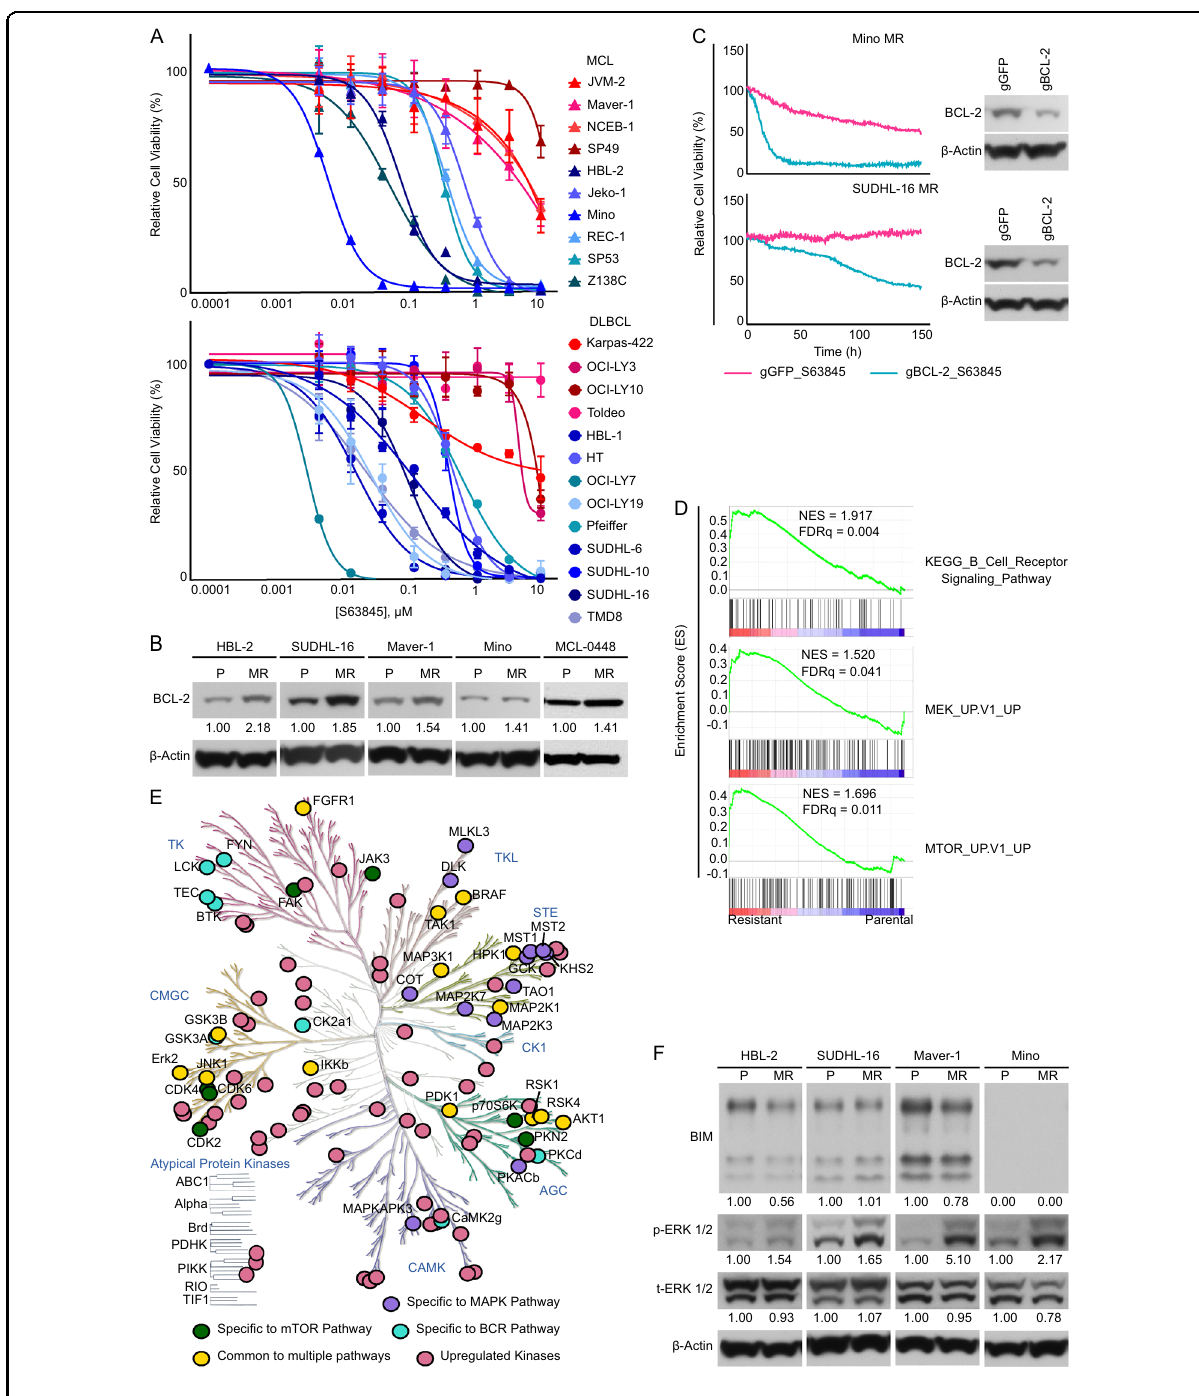
CaMK2gMAPKAPK3CDK2 Atypical Protein Kinases Specific to MAPK Pathway Specific to BCR PathwaySpecific to mTOR Pathway Common to multiple pathways Upregulated by treating S63845-sensitive cell lines with high doses of s for S63845 were more than 10 – 100-fold higher in all IC 50 S63845 for an extended period in MCL, DLBCL, and derived resistant lines (Fig. S1B). Similarly, these MR MCL-derived lines (10 × IC lines showed a comparable level of resistance to the for 3 months). Though 50 chemically distinct MCL-1 inhibitor, AZD5991 (Fig. S1C). parental lines were exquisitely sensitive to S63845, the